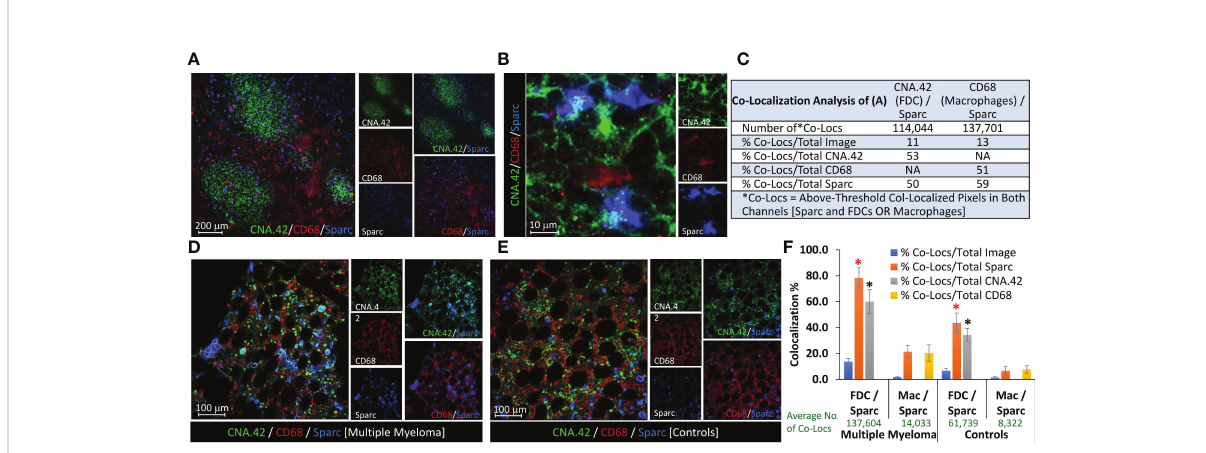
FIGURE 4 Contribution of FDCs and macrophages to Sparc expression in lymphoid tissues. Colocalization of FDCs (CNA.42/green), macrophages (CD68/red), and Sparc (blue) in (A) three adjacent tonsillar lymphoid follicles and the inter-follicular/peri-follicular regions. (B) High-magni fi cation image of the tonsillar intrafollicular region showing colocalization of the same markers. (C) Colocalization analysis of (A) using the Colocalization Module of ImageJ as a representative of Sparc expression by FDCs and macrophages in SLTs (tonsils). BM biopsies from (D) an MM patient and (E) a control individual, showing Sparc colocalization with FDCs and macrophages. Single channel and dual overlays are also presented. Colocalization analysis of sections from at least three biopsies using the Colocalization Plugin of ImageJ is illustrated in (F) [Co-Locs = above-threshold co-localized pixels in both channels [Sparc and FDCs OR Macrophages]. The red star (*) signi fi es a p value of 0.032, whereas the black star (*) represents a value of 0.071 between the compared conditions. Error bars represent the standard error of means [SEM], and p < 0.05 is considered signi fi